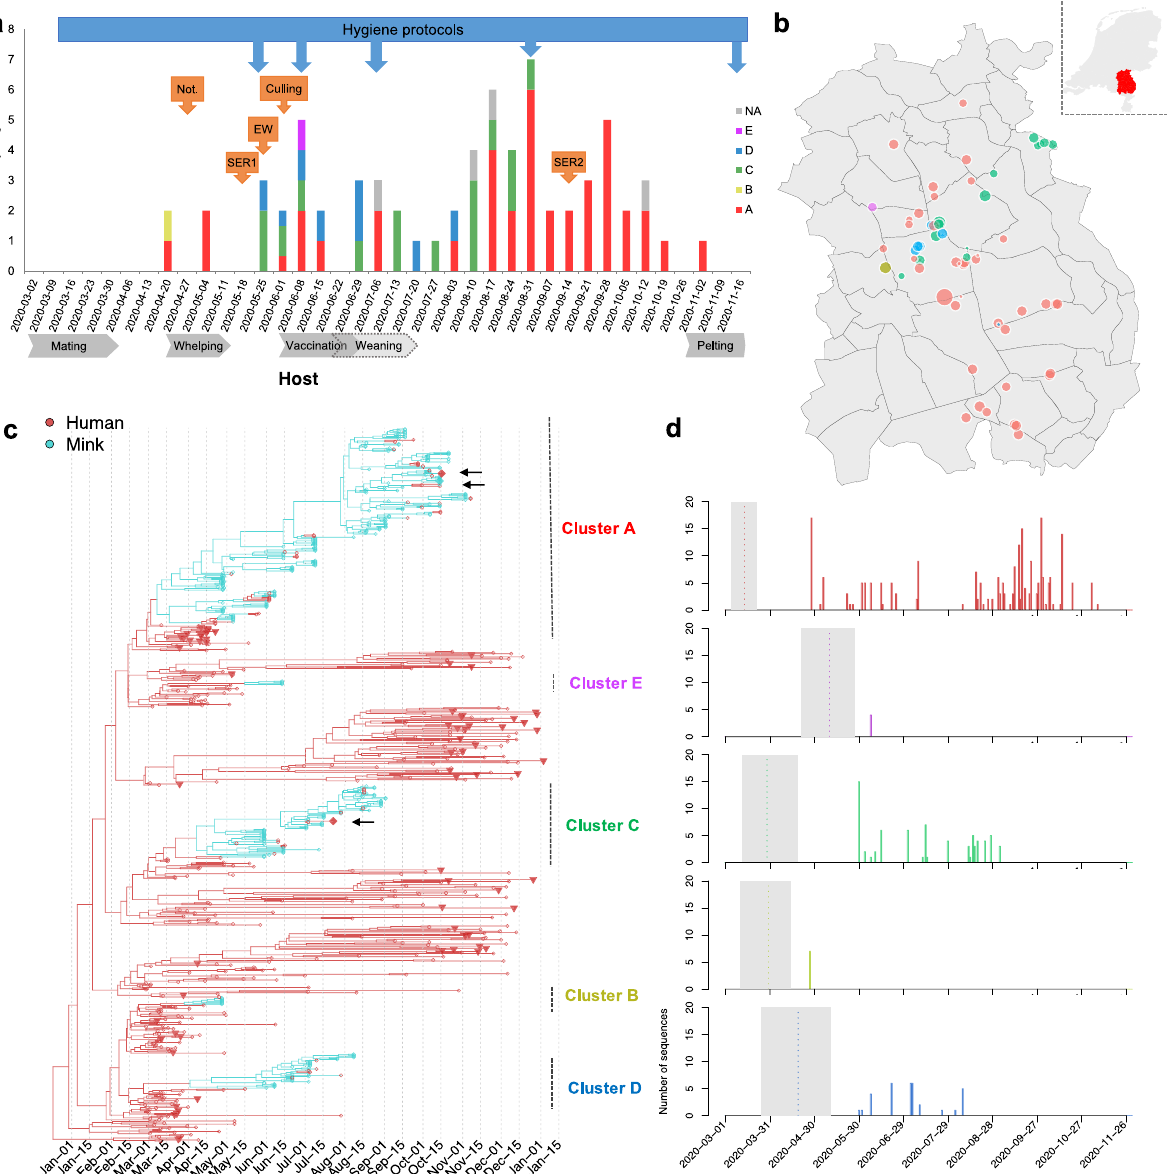
Fig. 1 Distinct Clusters of SARS-Cov-2 circulating in mink farms in the Netherlands. a Overview of SARS-CoV-2 outbreaks on mink farms in the Netherlands in relation to implementation of control measures and the mink farm cycle. The diagnosed farms per week are coloured based on virus cluster. One farm in June 2020 is indicated as half A/half D as both clusters were found. The blue arrows above the graph point to the starting week of implementation of more strict hygiene protocols with regard to people working on or visiting farms. Orange arrows point to the start of other control measures including obligation for noti fi cation of clinical signs and mortality (Not.), fi rst and second serological screening (SER1 and 2), early warning system with weekly sending in of carcasses (EW) and culling of infected farms. Below the graph important periods in the farmed mink production cycle are indicated. These include mating (March), whelping (April/May), vaccination (June) and weaning (June and July). Also, the start of the pelting season is shown. The 5 viral clusters are in unique colour (A in red, B in yellow, C in green, D in blue and E in pink) and are consistently used in ( a – d ). b The location of each infected mink farm. The node size represents the number of sequences obtained from minks in each farm. The locations of farms on the map have been jittered for privacy reasons. c Time-scaled maximum clade credibility (MCC) tree of SARS-CoV-2 sequences isolated from humans and minks in the Netherlands ( n = 673). Human sequences are highlighted in red and mink sequences in green, the subsampled human samples ( n = 72) isolated from the same four-digit postal code are highlighted as triangle, and 3 samples (1 escaped mink and 2 un-associated human sequences) which fell within mink clusters are highlighted as diamond and indicated by arrows. Clusters of sequences from minks and associated humans are indicated on the right with unique colours. d The number of samples in time for each cluster. The estimated TMRCAs of each cluster are indicated via dotted line (mean) and grey shade (95% highest posterior density (HPD)